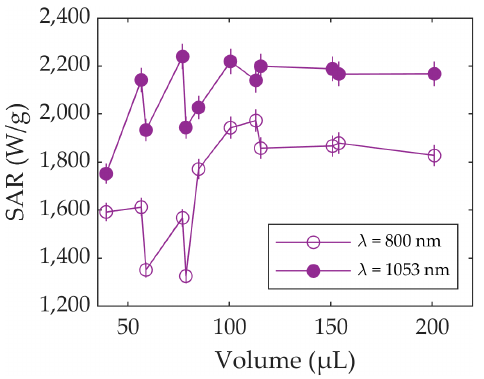
Figure 5. SAR vs. volume for Fe 3 O 4 using lasers at 800 nm and 1053 nm. Errors are represented as vertical bars.